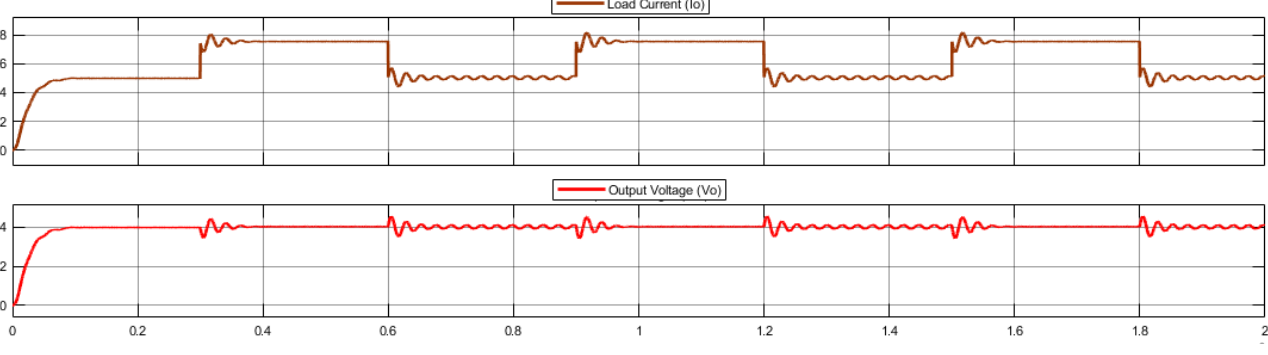
Figure 15. Converter output voltage and current responses during load disturbances in the presence of radiation fault injection (experiment 2).